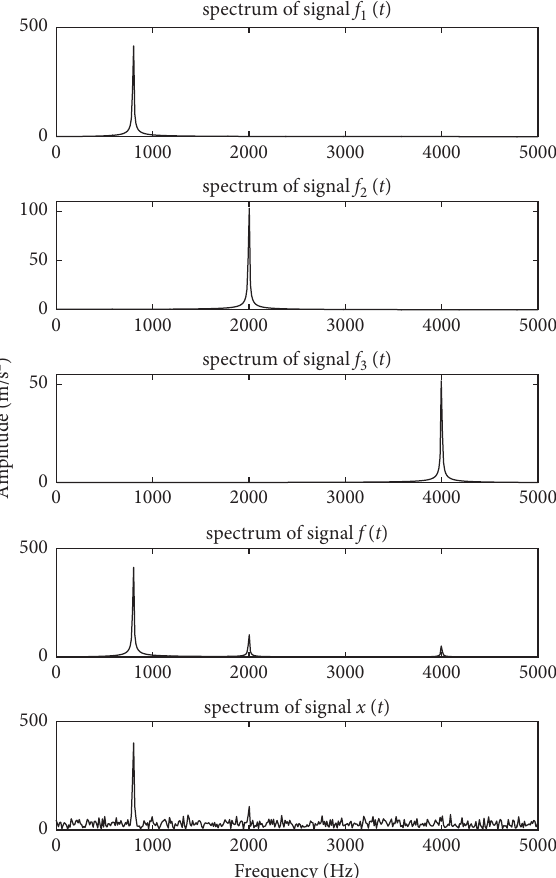
1 ( t ), f 2 ( t ), and f 3 ( t ) as well as